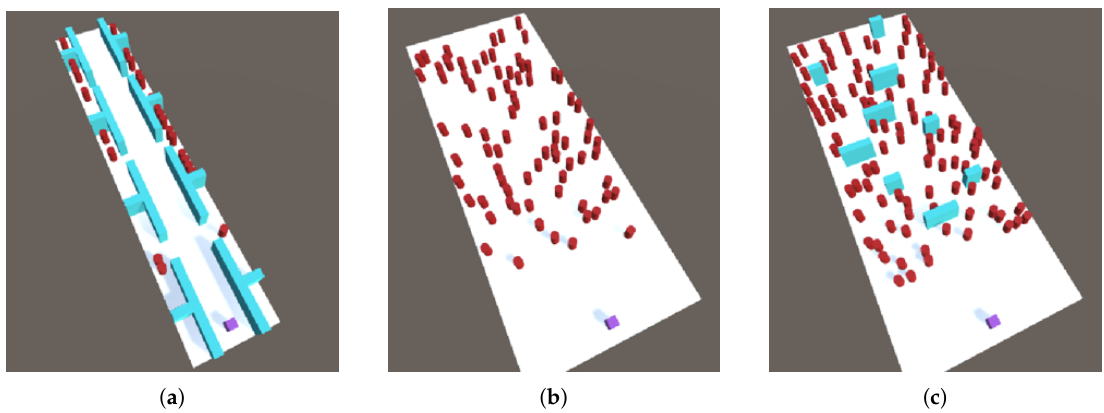
Figure 1. The three simulated environments used in this study: ( a ) office environment, ( b ) open street environment and ( c ) obstacles environment. Simulated human agents are shown as red cylinders, placed randomly at the start of a